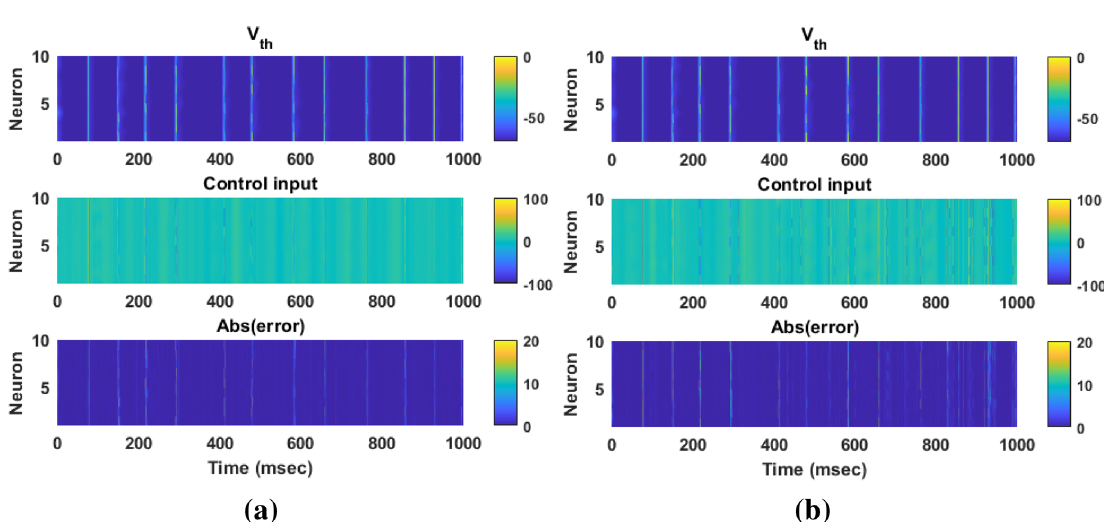
Figure 7. Typical results of the membrane potential, control input, and absolute tracking error for individual cells of the TH populations under 50% time-varying system parameters using ( a ) AFTSMC ( b )